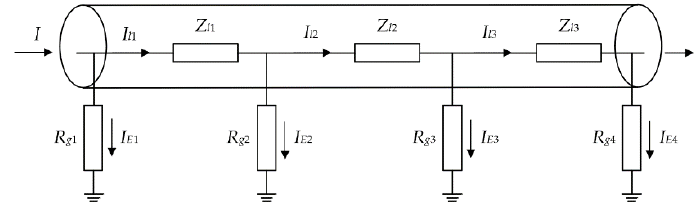
Figure 2. Equivalent physical model of the grounding electrode.